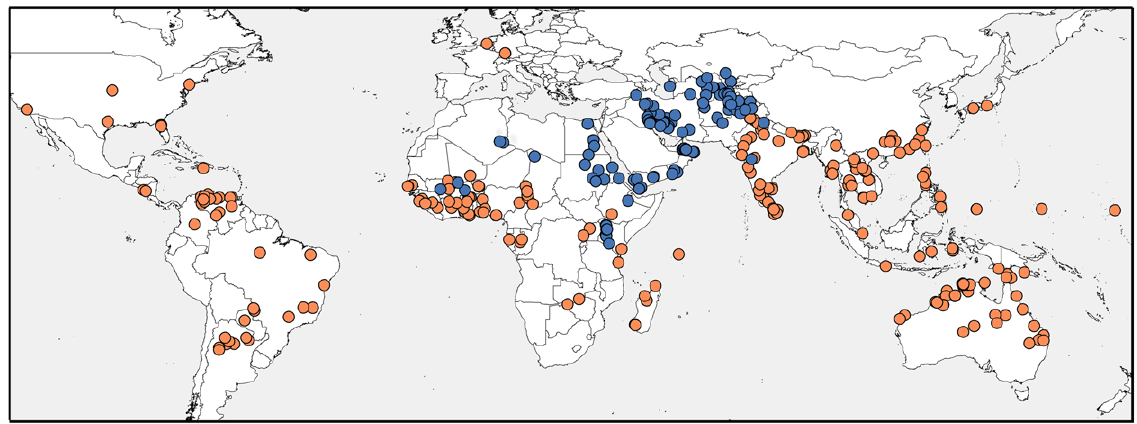
Fig. 351. Known distribution of Crossopriza Simon, 1893. Orange: C. lyoni (Blackwall, 1867); blue: all other species (cf. Figs 352–353).